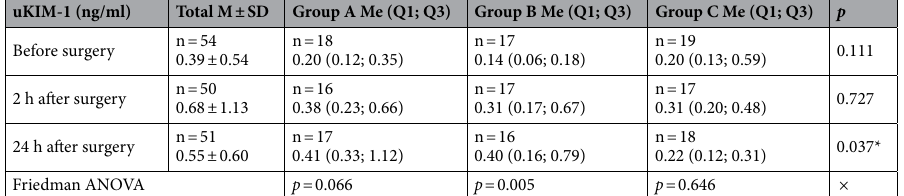
Table 3. uKIM-1 levels before the surgery, and 2 h and 24 h after surgery. uKIM-1 the urinary kidney injury molecule-1, M mean, SD standard deviation, Me median, Q1 quartile 1st, Q3 quartile 3rd, n number of participants, p level of statistical significance.